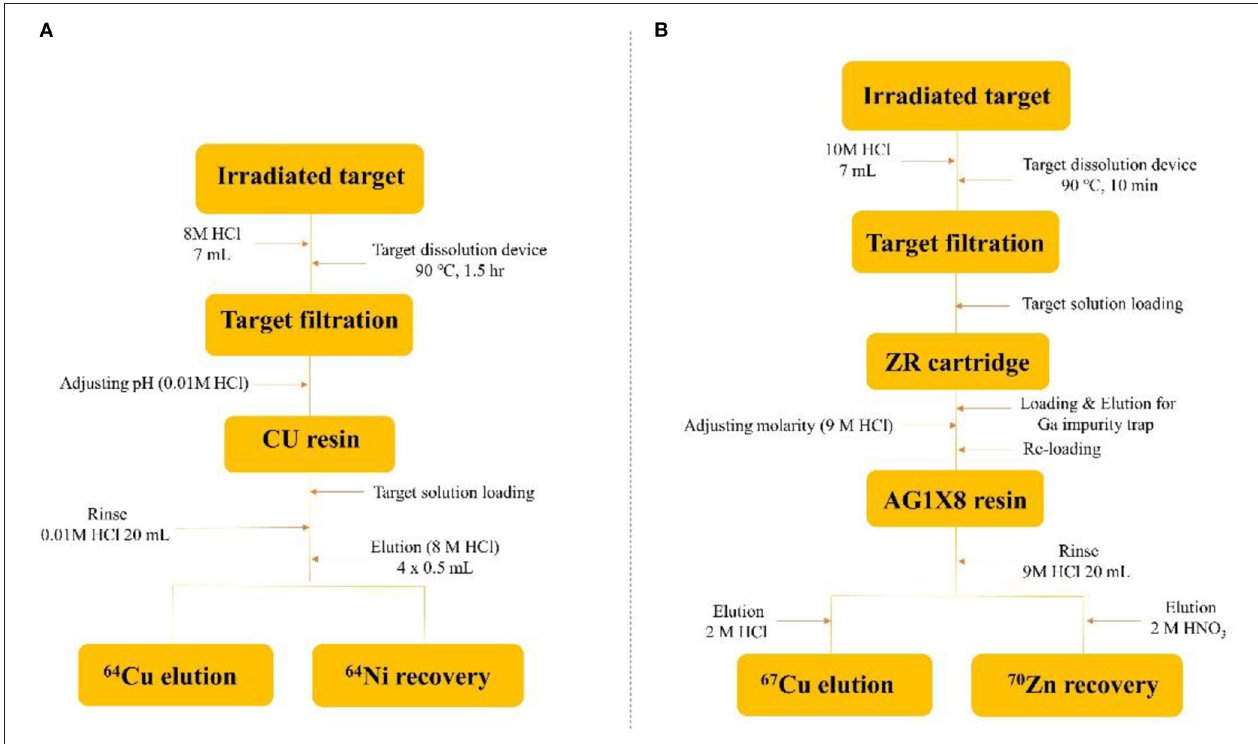
FIGURE 3 | (A,B) Schematic of chemical separation processing.